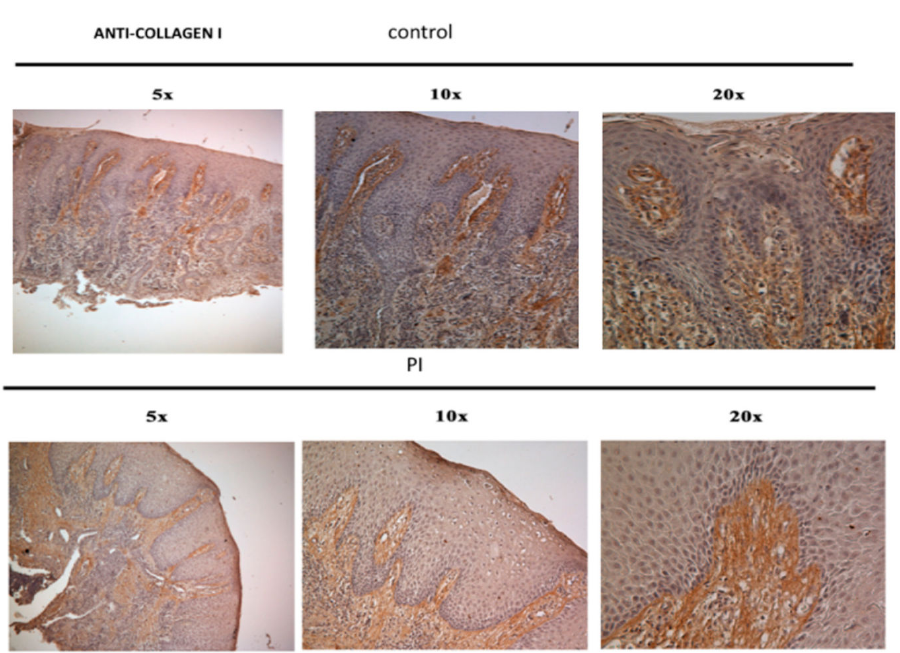
Figure 8. Collagen fibers present in the ICT and control samples.